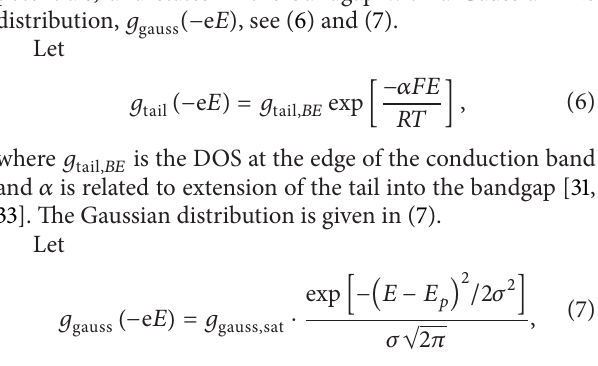
Table 3: Peak potentials determined from CV, 𝐸